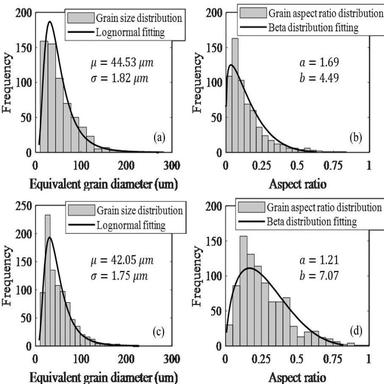
Grain size and aspect ratio distributions of the AA7075-O extruded tube. Grain size distributions were characterized using lognormal fitting with μ being the mean grain size and σ being the standard deviation, and the grain aspect ratio distributions were characterized using beta distribution fitting with a and b being the parameters of the beta distribution function. a) Grain size distribution and b) grain aspect ratio distribution of hoop cross-section, and c) grain size distribution and d) grain aspect r